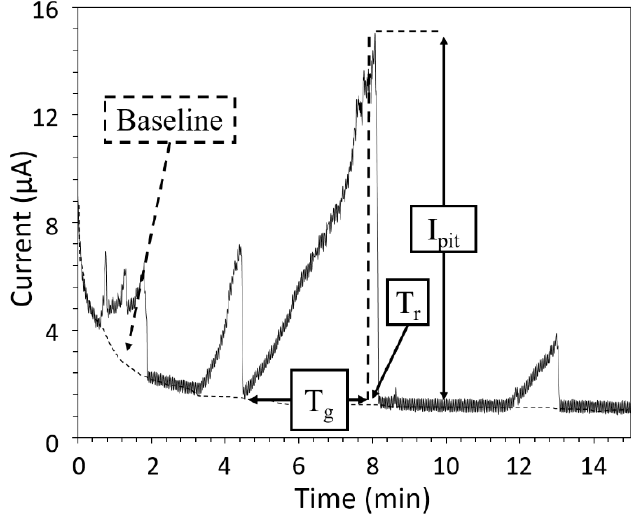
Figure 2. Example of a current transient measured during the potentiostatic experiments (samples maintained at a constant potential of 250 mV versus E corr for 1 h). Identification of the values characteristic of the metastable pits, i.e., E pit , T g , and T r